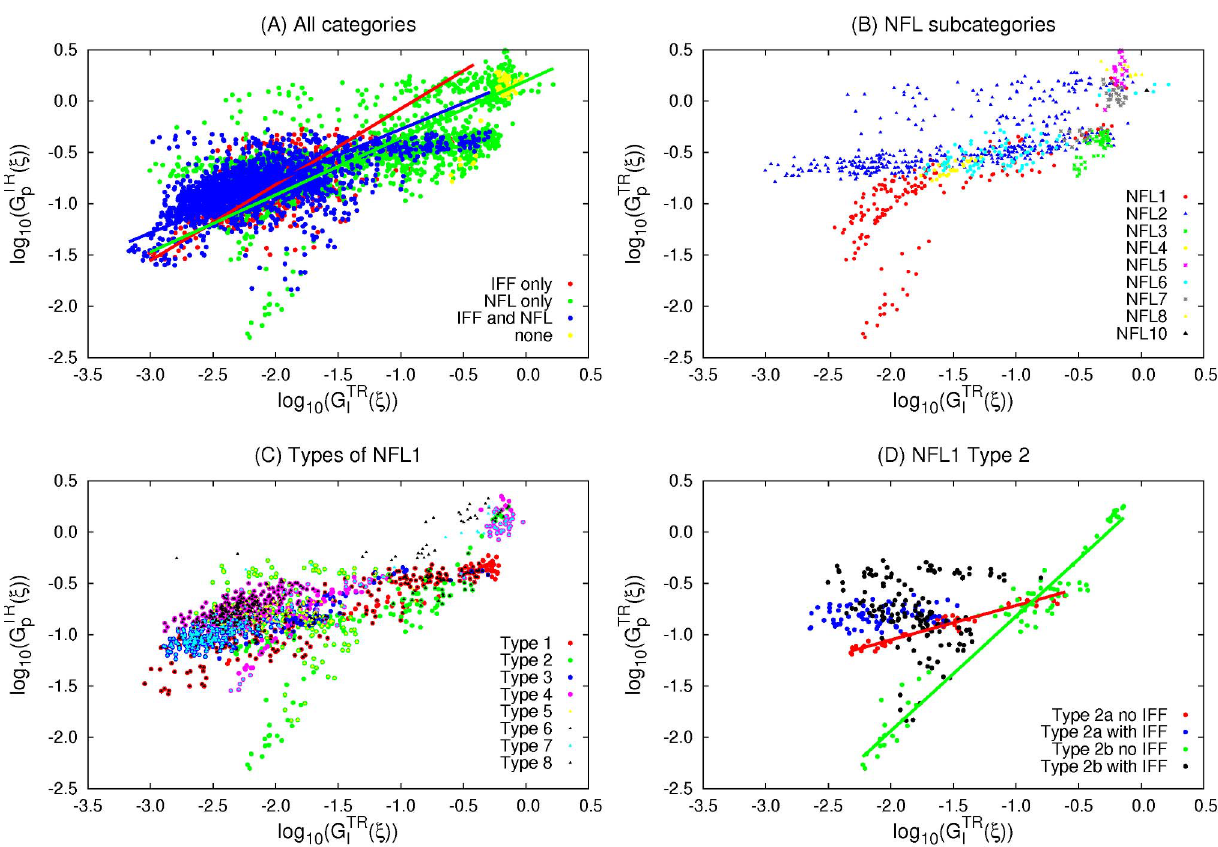
Figure 6. Correlations within 3-node motifs/motif subcategories. Topologies are divided according to the motifs they contain. All the regressions are significant with p , 0.0001). (A) Linear regression is applied for each category. IFF_only (red): y =0.74 x + 0.66 ( N =609, r=0.60). NFL_only (green): y =0.56 x + 0.20 ( N =1397, r=0.64). IFF_NFL (blue): y =0.51 x + 0.23 ( N =2100, r=0.63). (B) NFL subcategories excluding topologies that contain more than one motif/type of motif. (C) NFL1 types including those containing additional motifs. (D) Type2a (blue and red) ) type 2 with X 3 auto- deactivation, Type2b (green and black) ) type 2 without X 3 auto-deactivation. Type2a without IFF (red): y =0.33 x –0.38 ( N =45, r=0.97). Type2b without IFF (green): y =1.12 x + 0.29 ( N =77, r=0.97).